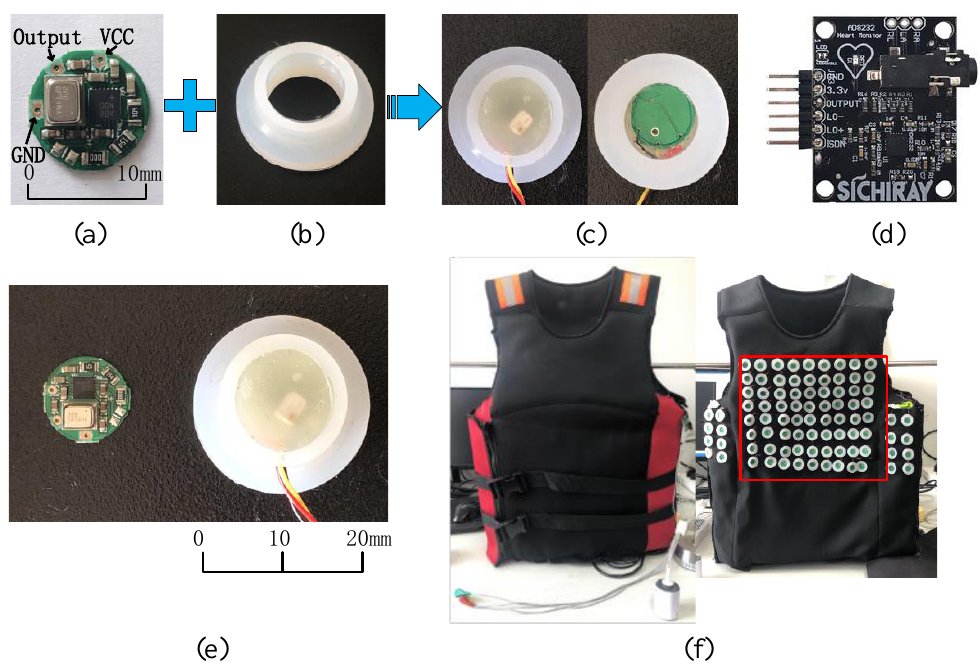
Figure 4. Multi-channel wearable heart sound acquisition device. ( a ) Sensor PCB, ( b ) rubber housing, ( c ) packaged sensor, ( d ) ECG AFE, ( e ) size of the sensor and the PCB, ( f ) vest and the sensors arrangement on the inside of the vest.